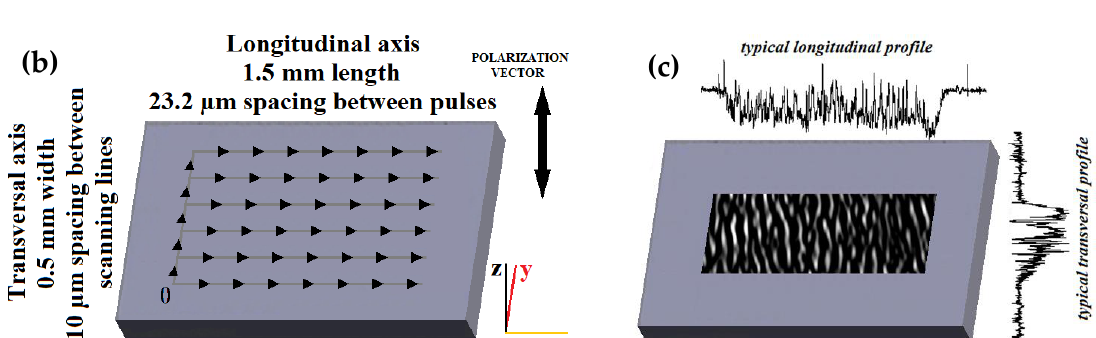
Figure 1. Layout and principal geometry characteristics of laser treatment: ( a ) photograph of cylindrical D16T sample, with series of treated areas marked; ( b ) laser scan schematic diagram, with axes defined and scanning (long arrows) and scan progression (short arrows) directions; ( c ) typical treated area schematic, with laser-induced periodic surface structure LIPSS direction indicated and typical profiles shown.